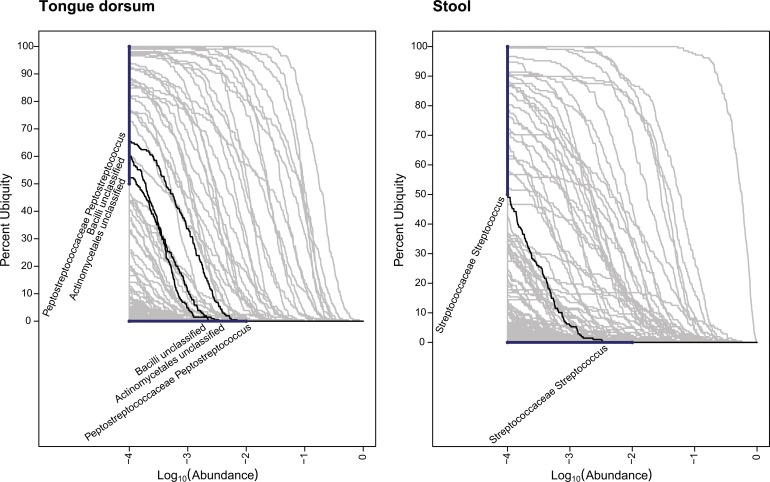
Genera Minor Core for 2 Body Habitats.In these Ub-Ab plots, heavy bars are drawn vertically on the y-axis from 50% to 100% ubiquity, and horizontally on the log10 transformed x-axis (abundance) from −4 to −2, representing an abundance of <1%. To qualify for greater than 50% ubiquity and less than 1% abundance, the Ub-Ab curve must originate from the range highlighted by the vertical bar and terminate on the range highlighted by the horizontal bar. The identified minor core taxa are identified for the tongue dorsum and stool body habitats.